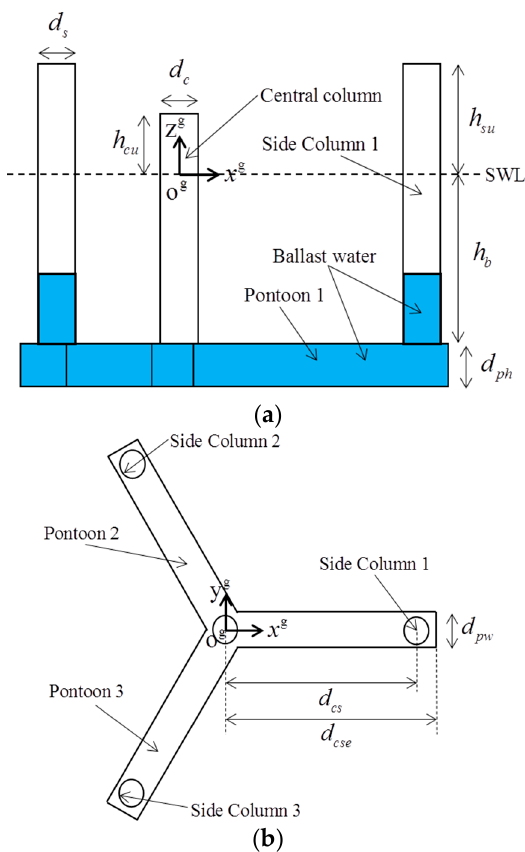
Figure 3. Side ( a ) and top ( b ) views of the braceless semi-submersible platform [23].